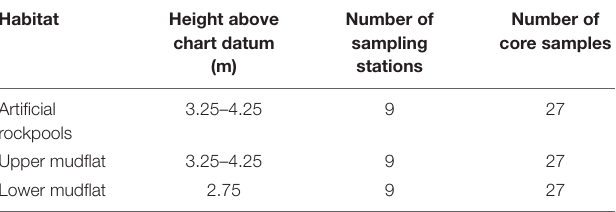
TABLE 1 | Tidal height and number of core samples taken from artificial rockpools and mudflat habitats. Habitat Height above chart